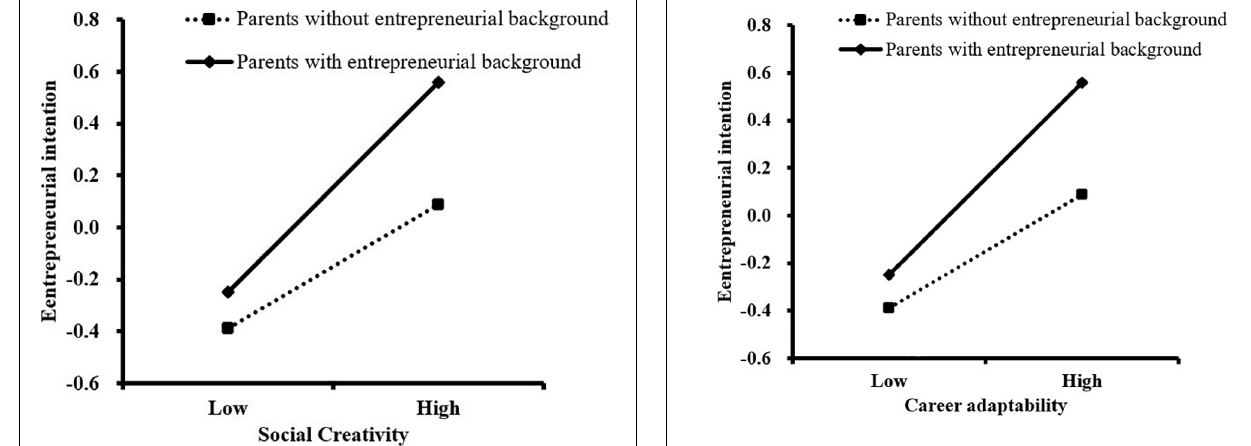
t = 5.97, P < 0.001). As illustrated in Figures 3 , 4 , the association between career adaptability and entrepreneurial intention, as